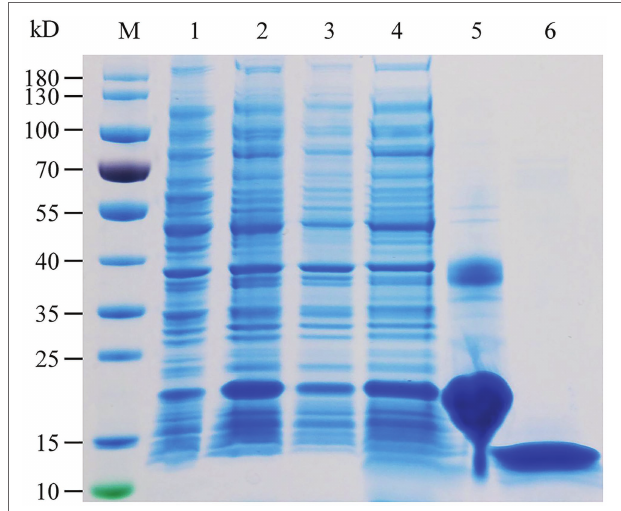
FIGURE 3 | SDS-PAGE analysis of the recombinant HhalCSP15. M: molecular weight markers, 1: cell pellet before induction with IPTG, 2: cell pellet after induction, 3: pellet after sonication, 4: supernatant after sonication, 5: protein purified by affinity chromatography, and 6: purified protein after digestion with enterokinase.